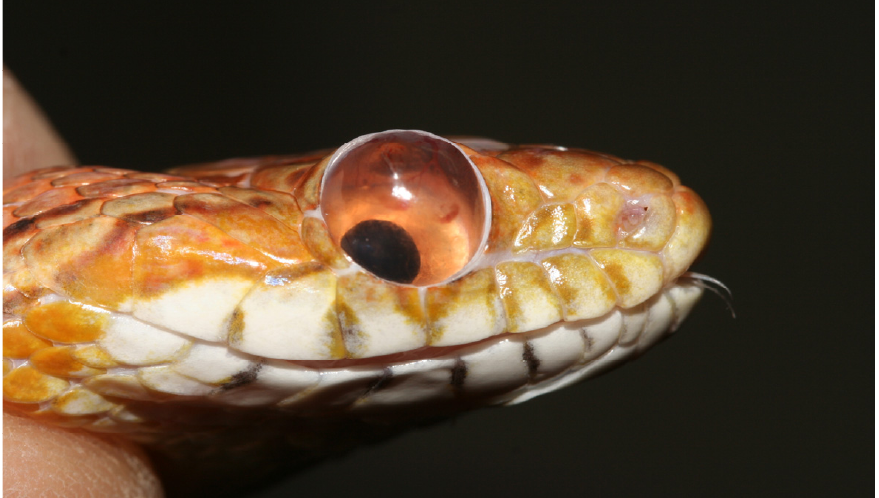
Figure 21. Pseudobuphthalmos presenting as a severe distention of the subspectacular space related